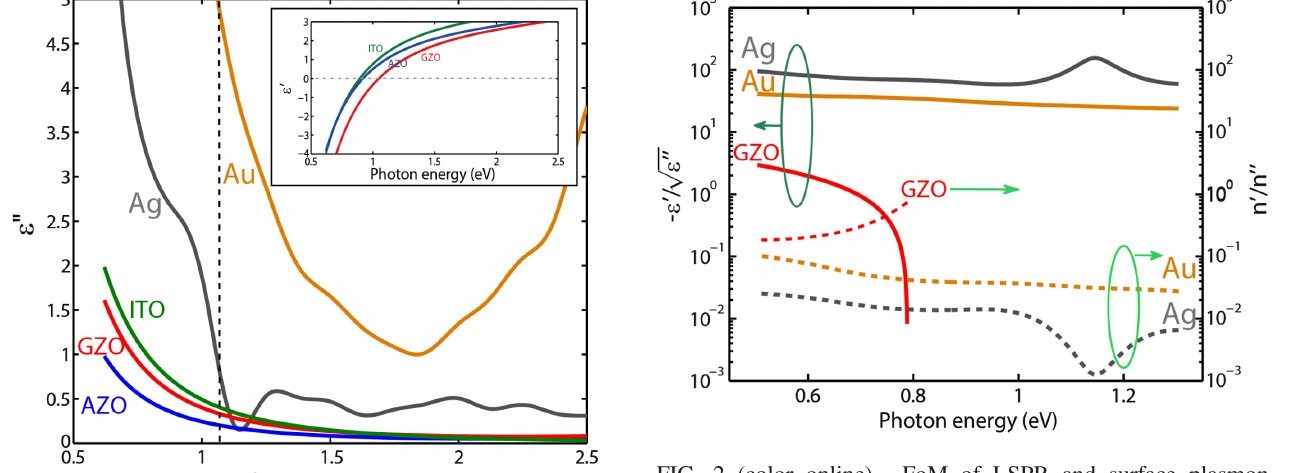
FIG. 2 (color online). FoM of LSPR and surface plasmon polariton waveguiding devices (solid lines) and TO devices (dashed lines) calculated for GZO, gold, and silver as plasmonic